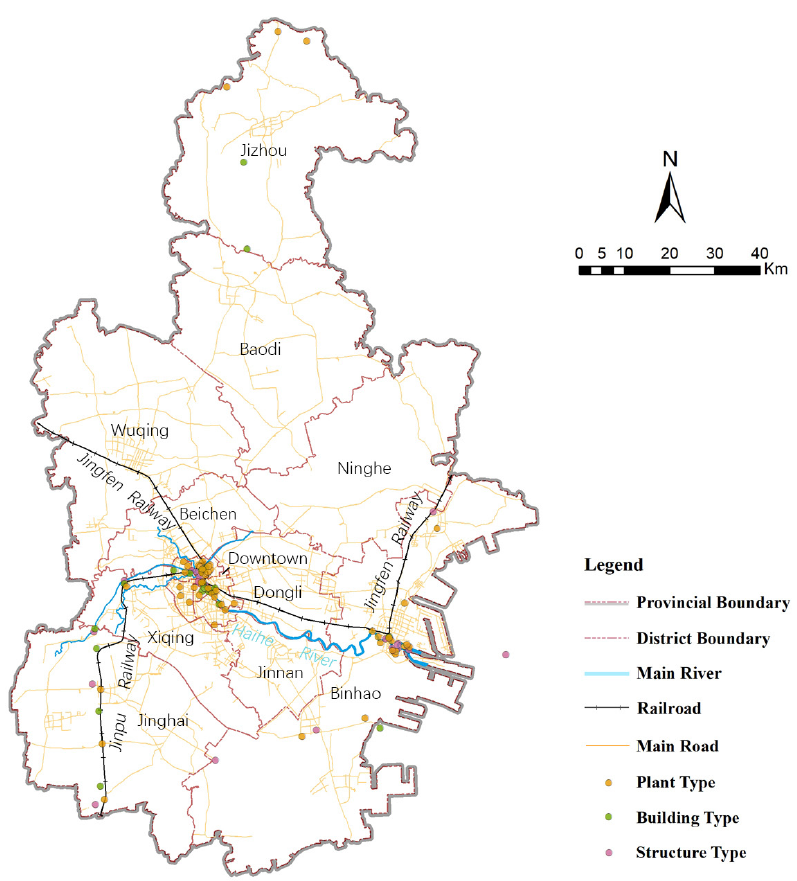
Figure 2. Tianjin Industrial Heritage Census GIS Database (base map source: National Basic Geo- graphic Information System). Table 2. Statistics on industrial heritage in Tianjin by historical